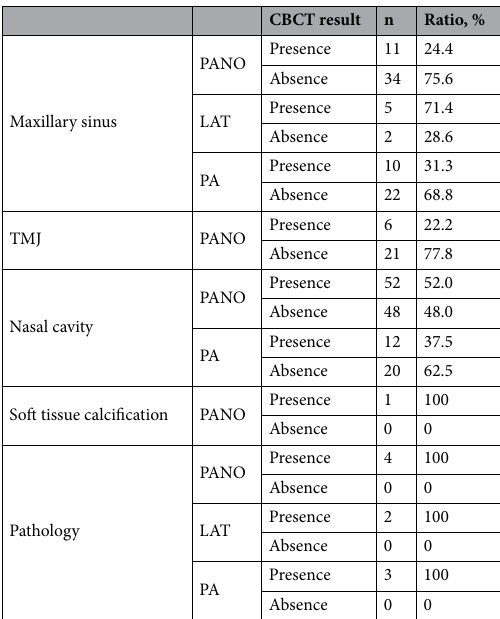
Table 5. Source of data in “not determined” category of each 2D radiograph. PANO panoramic radiograph, LAT lateral cephalogram, PA postero-anterior cephalogram.